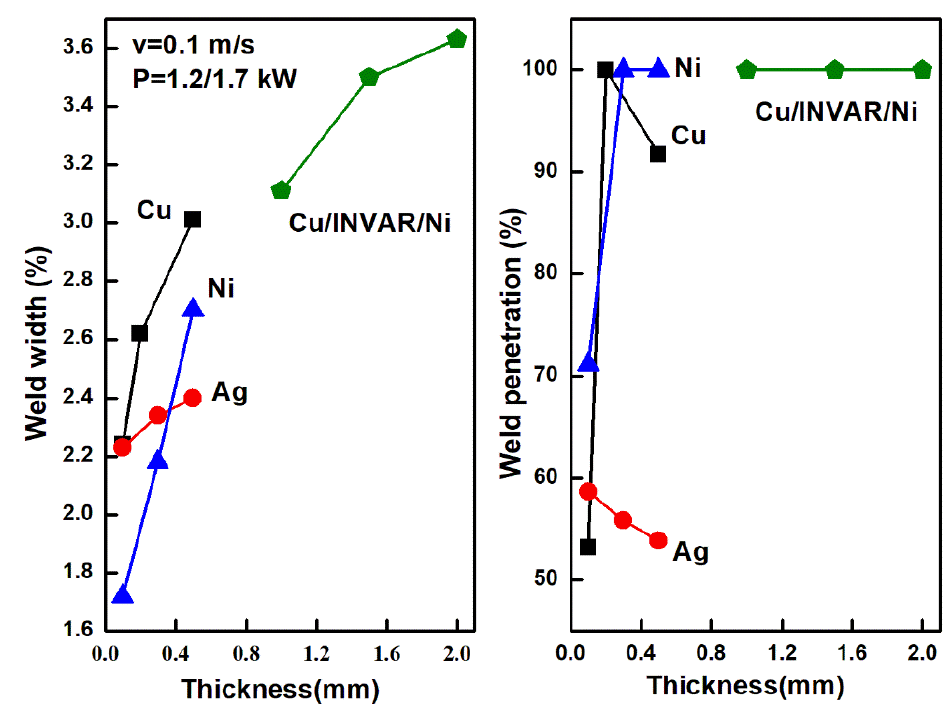
Figure 6. Weld width and weld penetration of four braze materials of different